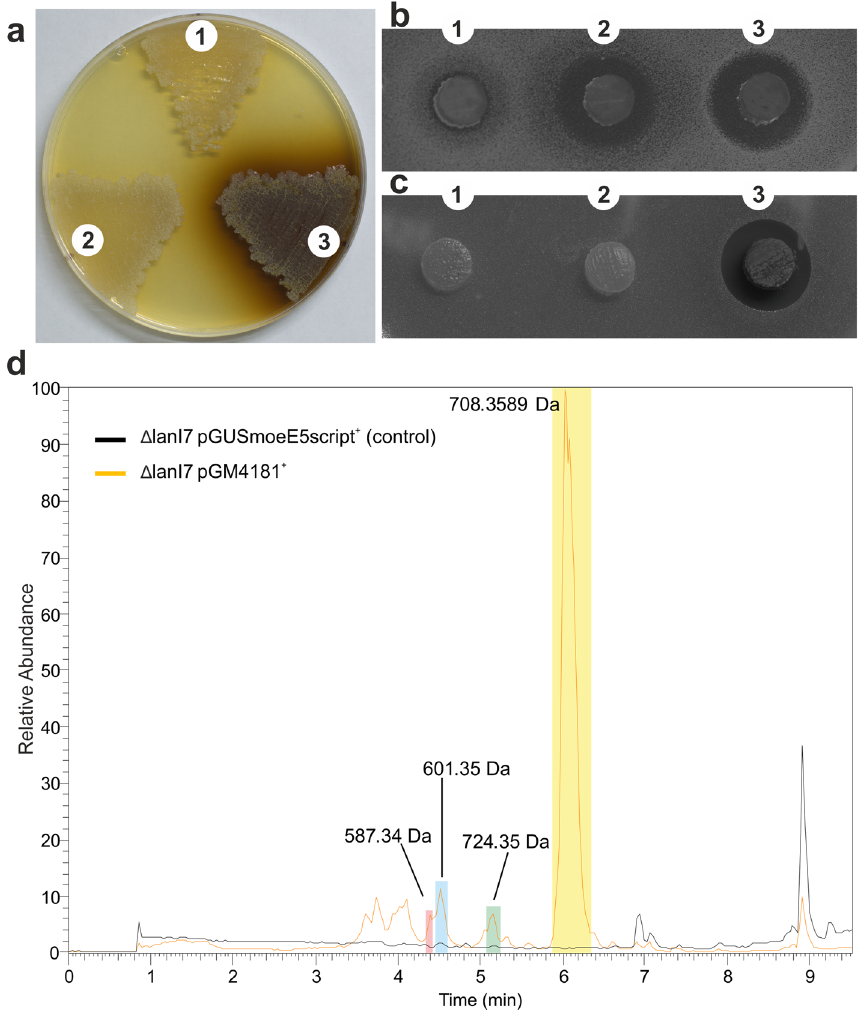
Figure 1. The adpA gene activates silent secondary metabolome of S. cyanogenus . ( a ) Phenotypes of S. cyanogenus ΔlanI7 (1), S. cyanogenus ΔlanI7 pGM4181d + (2; DBD of adpA ) and S. cyanogenus ΔlanI7 pGM4181 + (3; full-length adpA ) after 168 h of growth on TSB agar; B. cereus ( b ) and D. hansenii ( c ) growth inhibition assays using agar plugs taken from 120 h old ISP5 lawns of S. cyanogenus ΔlanI7 (1), S. cyanogenus ΔlanI7 pGM4181d + (2) and S. cyanogenus ΔlanI7 pGM4181 + (3). ( d ) LC–MS analysis of the secondary metabolites produced in liquid YMPG medium by S. cyanogenus ΔlanI7 pGUSmoeE5script + (control) and S. cyanogenus ΔlanI7 pGM4181d + ; four new mass peaks appeared in the chromatogram for the latter